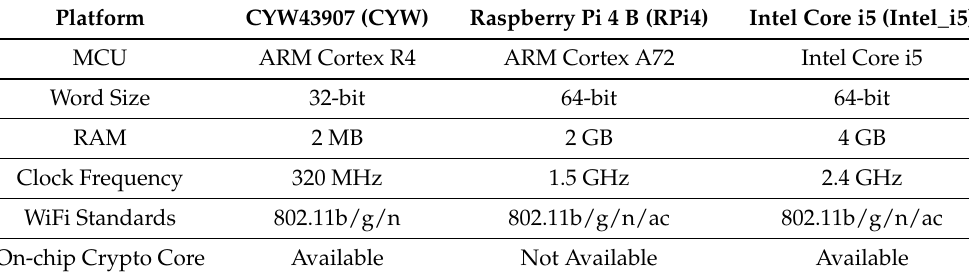
Table 3. Summary of the specifications of hardware platforms used in this work.